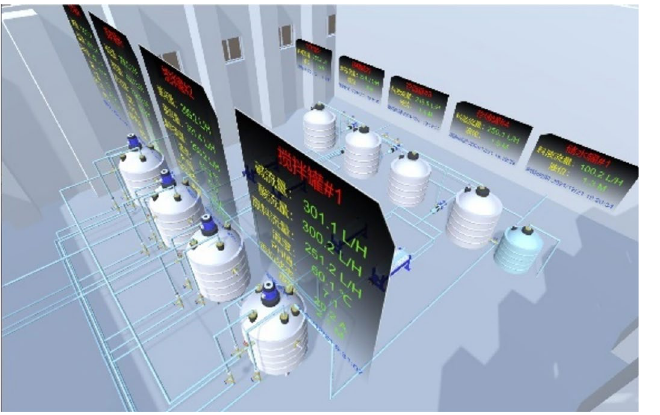
Figure 11. virtual workshop for rare earth